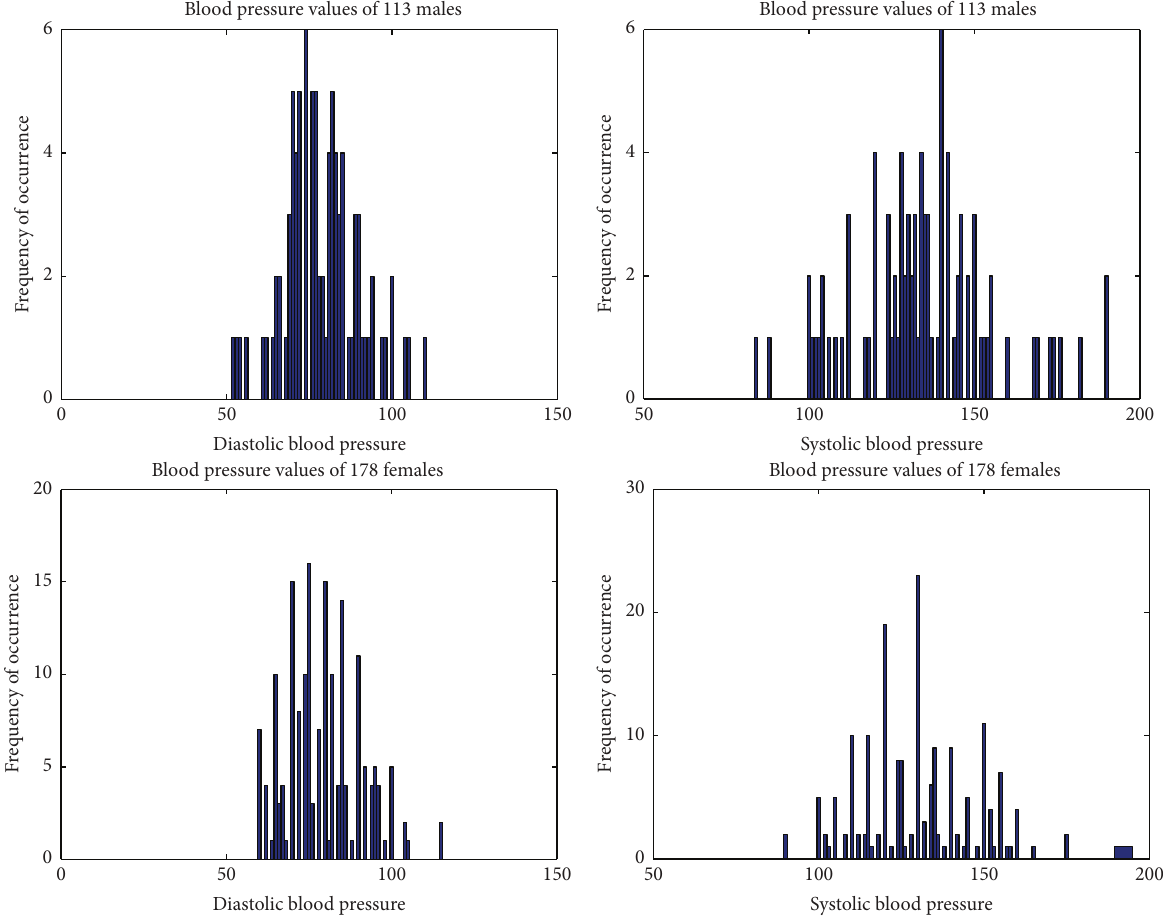
Figure 6: Frequency of SBP and DBP for male and female subjects using sphygmomanometric method.